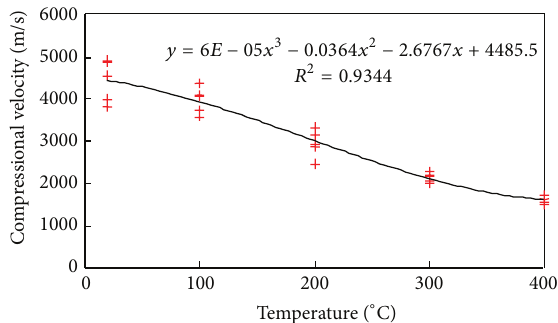
Figure 3: Longitudinal wave velocity variation curve with temper- ature in